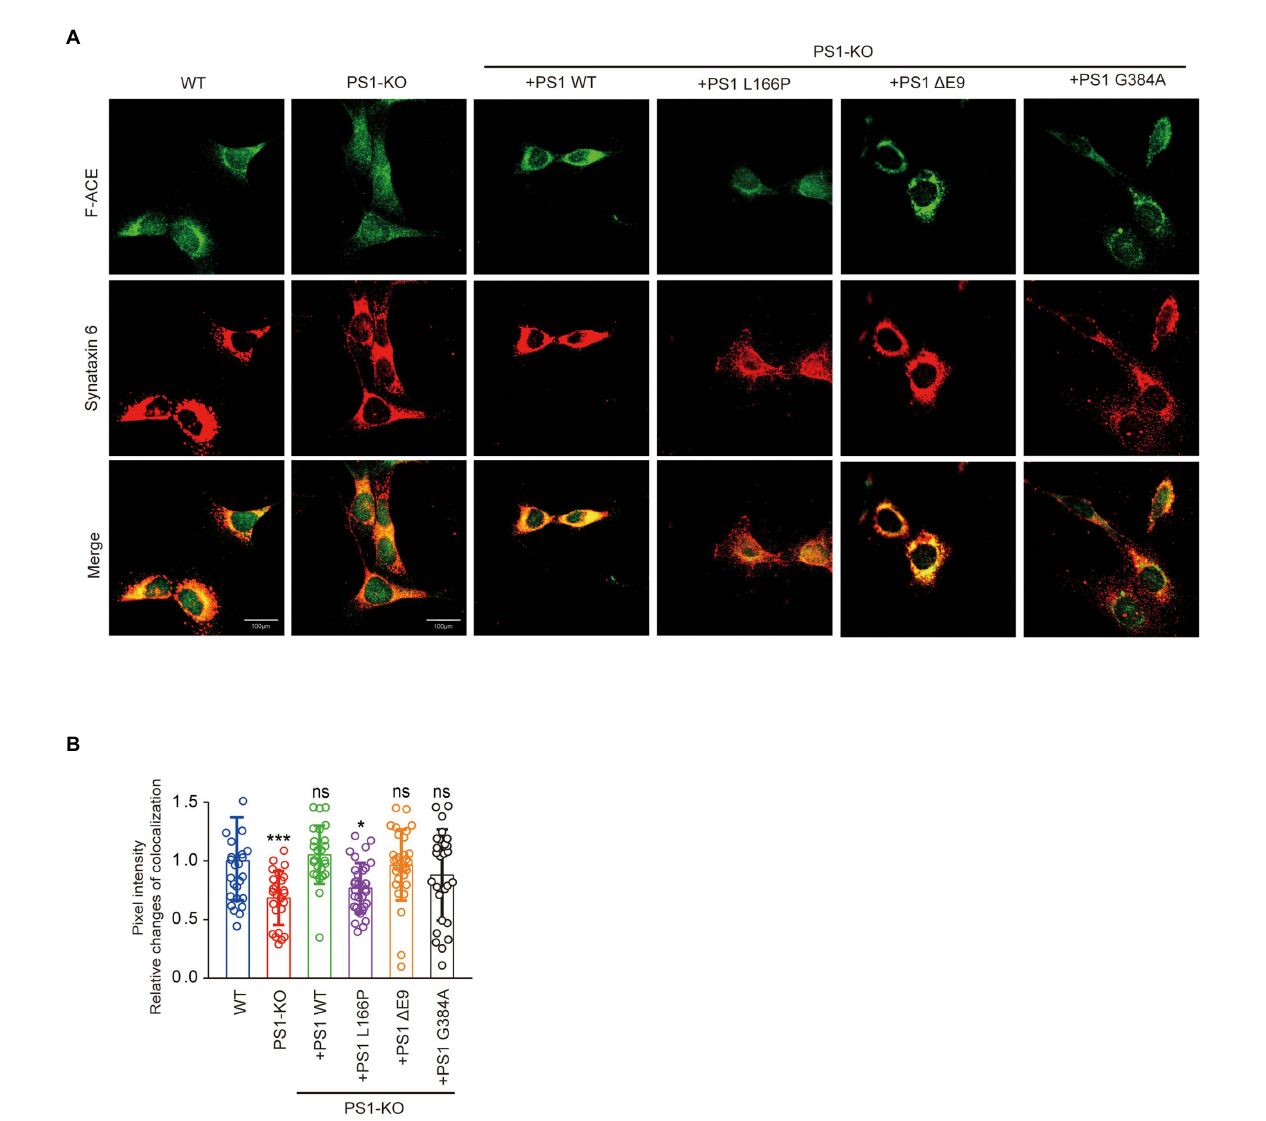
FIGURE 5 PS1 deficiency and PS1 mutant affected the localization of ACE. (A) Immunostaining for Golgi apparatus (red) and F-ACE (green) in WT, PS1-KO, and PS1-KO fibroblasts transfected with PS1WT and PS1 mutants. Scale bars, 100 μ m. (B) Quantification of ACE intensity in Golgi apparatus of WT, PS1-KO, and PS1-KO fibroblasts transfected with PS1WT and PS1 mutants. n ≥ 25 different stained cells/group. * p < 0.05, *** p < 0.001. NS, not significant, Holm-Sidak’s multiple comparisons